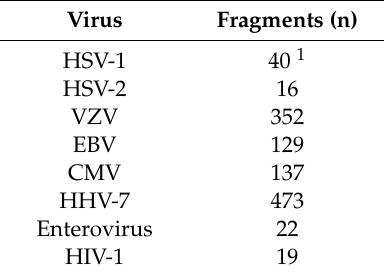
Table 1. Putative number of VIDISCA fragments per virus.